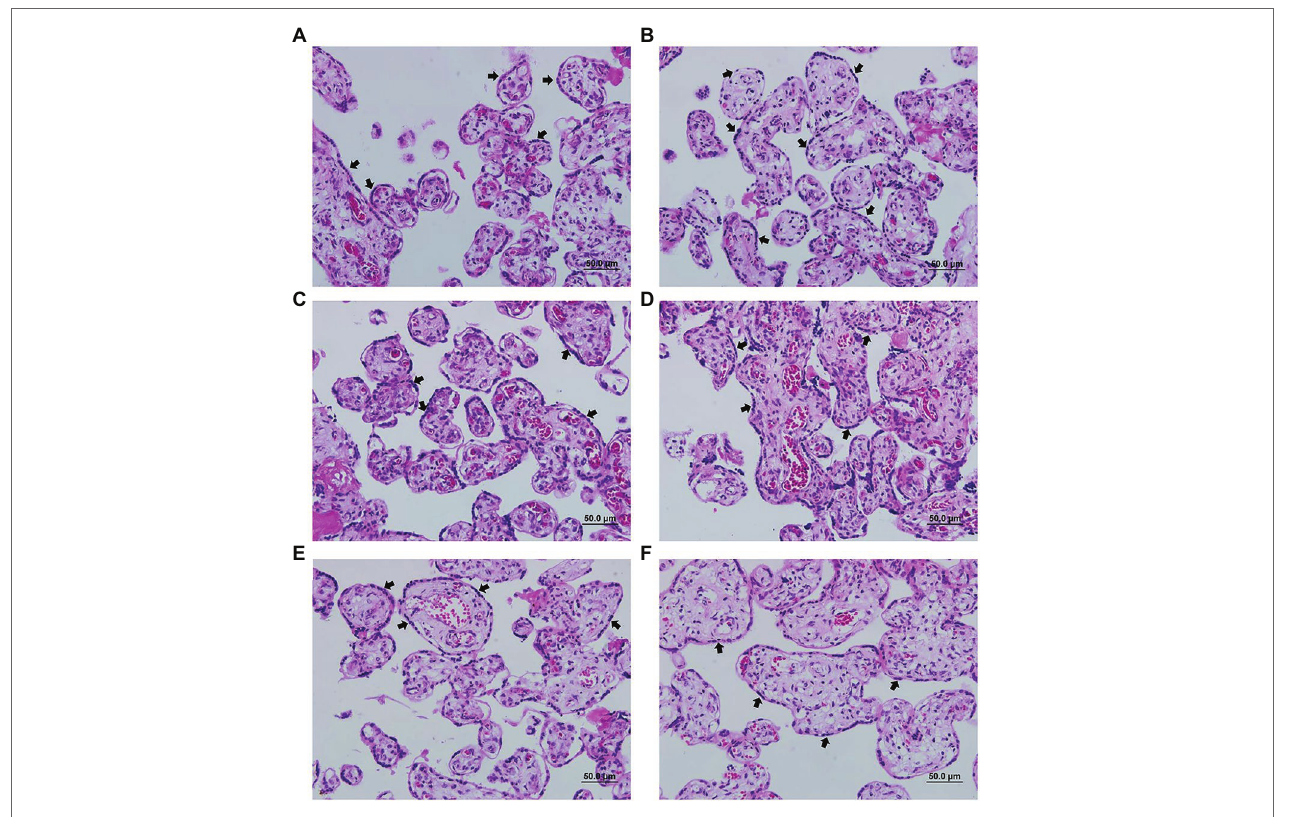
FIGURE 3 | Representative photomicrograph of villi treated or not with different concentrations of nanoparticles. (A) negative control (untreated); (B) 25 μ M/ml; (C) 50 μ M/ml; (D) 200 μ M/ml; (E) 800 μ M/ml; and (F) positive control treated with sulfadiazine/ pyrimethamine (SDZ + PYR). The arrows indicate the cell layer of the cytotrophoblast and the integrity of the tissue. Hematoxylin and eosin